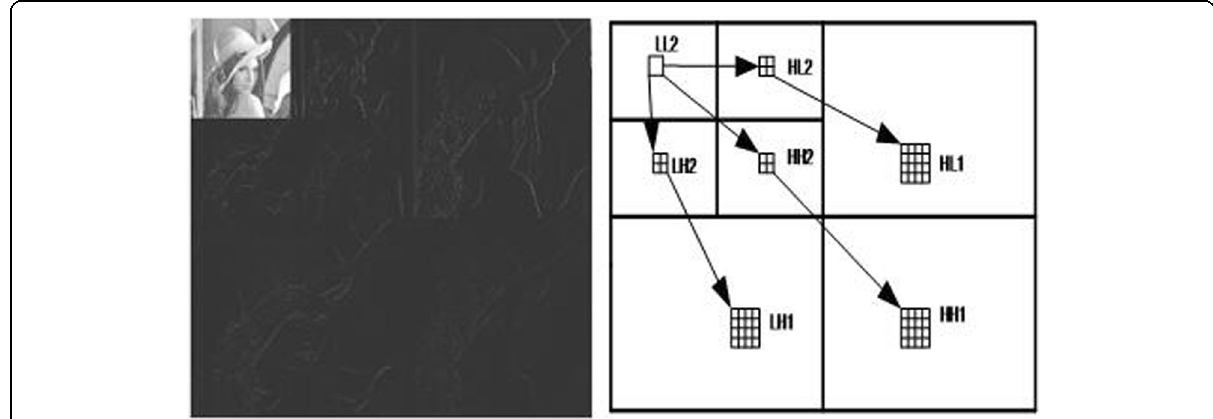
Fig. 3 The quadtree structure of DWT for Lena is shown in Fig.